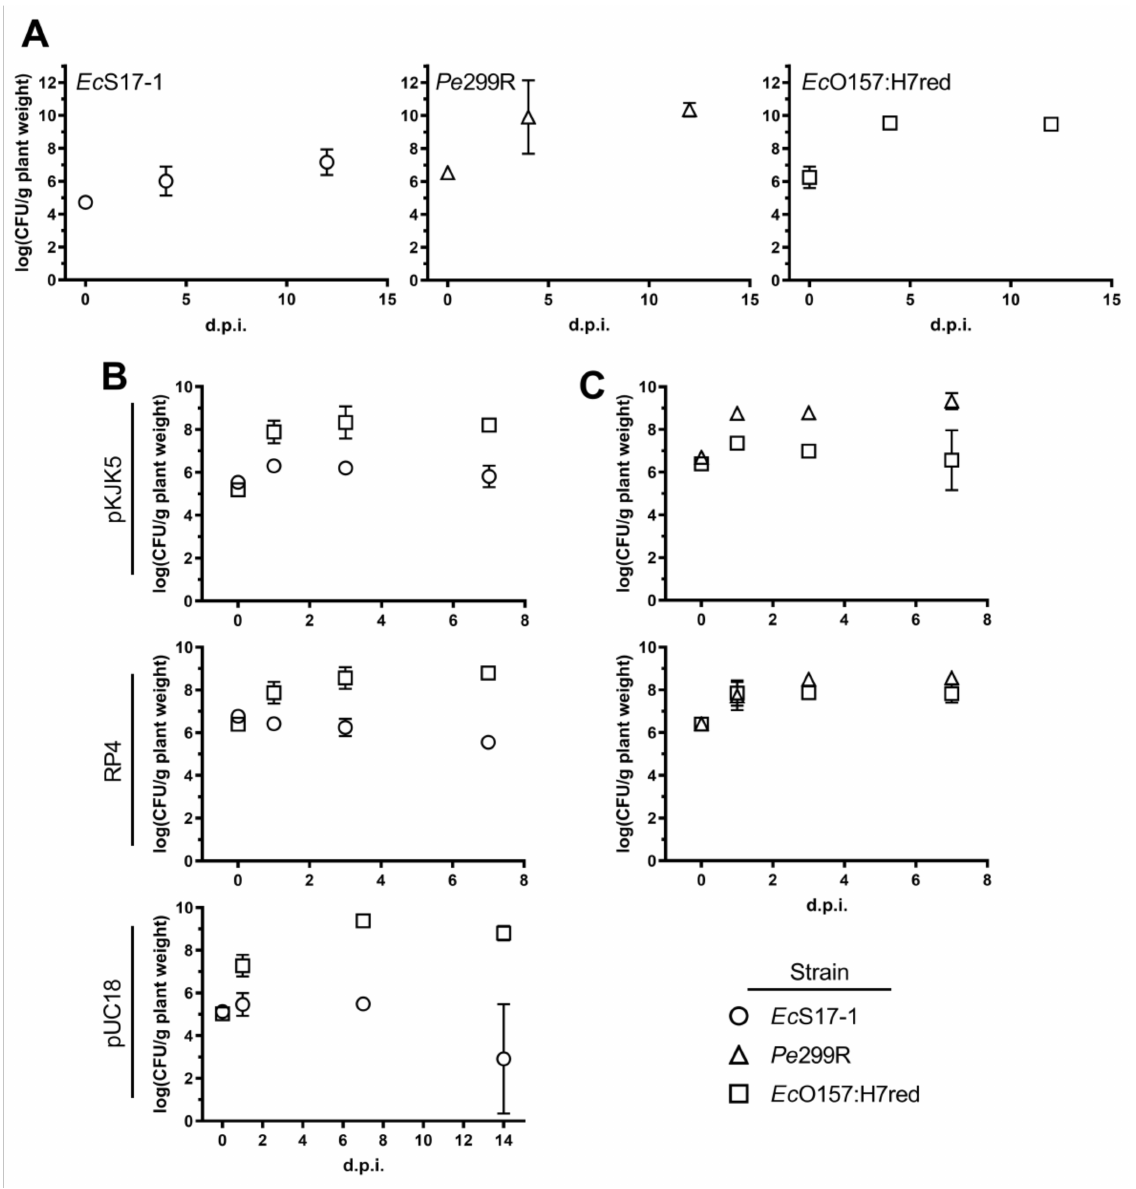
Figure 3. Bacterial population development on gnotobiotic A. thaliana. ( A ) Populations after monoinoculation of Ec S17-1 (circles), Pe 299R (triangles), or Ec O157:H7red (squares) at 4 and 12 days post-inoculation (d.p.i.). ( B ) Population develop- ments after co-inoculation of Ec S17-1 (circles) harbouring pKJK5 (top), RP4 (middle), and pUC18 (bottom) with the recipient Ec O157:H7red (squares) onto gnotobiotic A. thaliana after 1, 3, and 7 d.p.i. ( C ) Population development after co-inoculation of Pe 299R (triangles) harbouring pKJK5 (top) and RP4 (bottom) with the recipient Ec O157:H7red (squares) onto gnotobiotic A. thaliana after 1, 3, and 7 d.p.i. Error bars represent the standard deviation of the